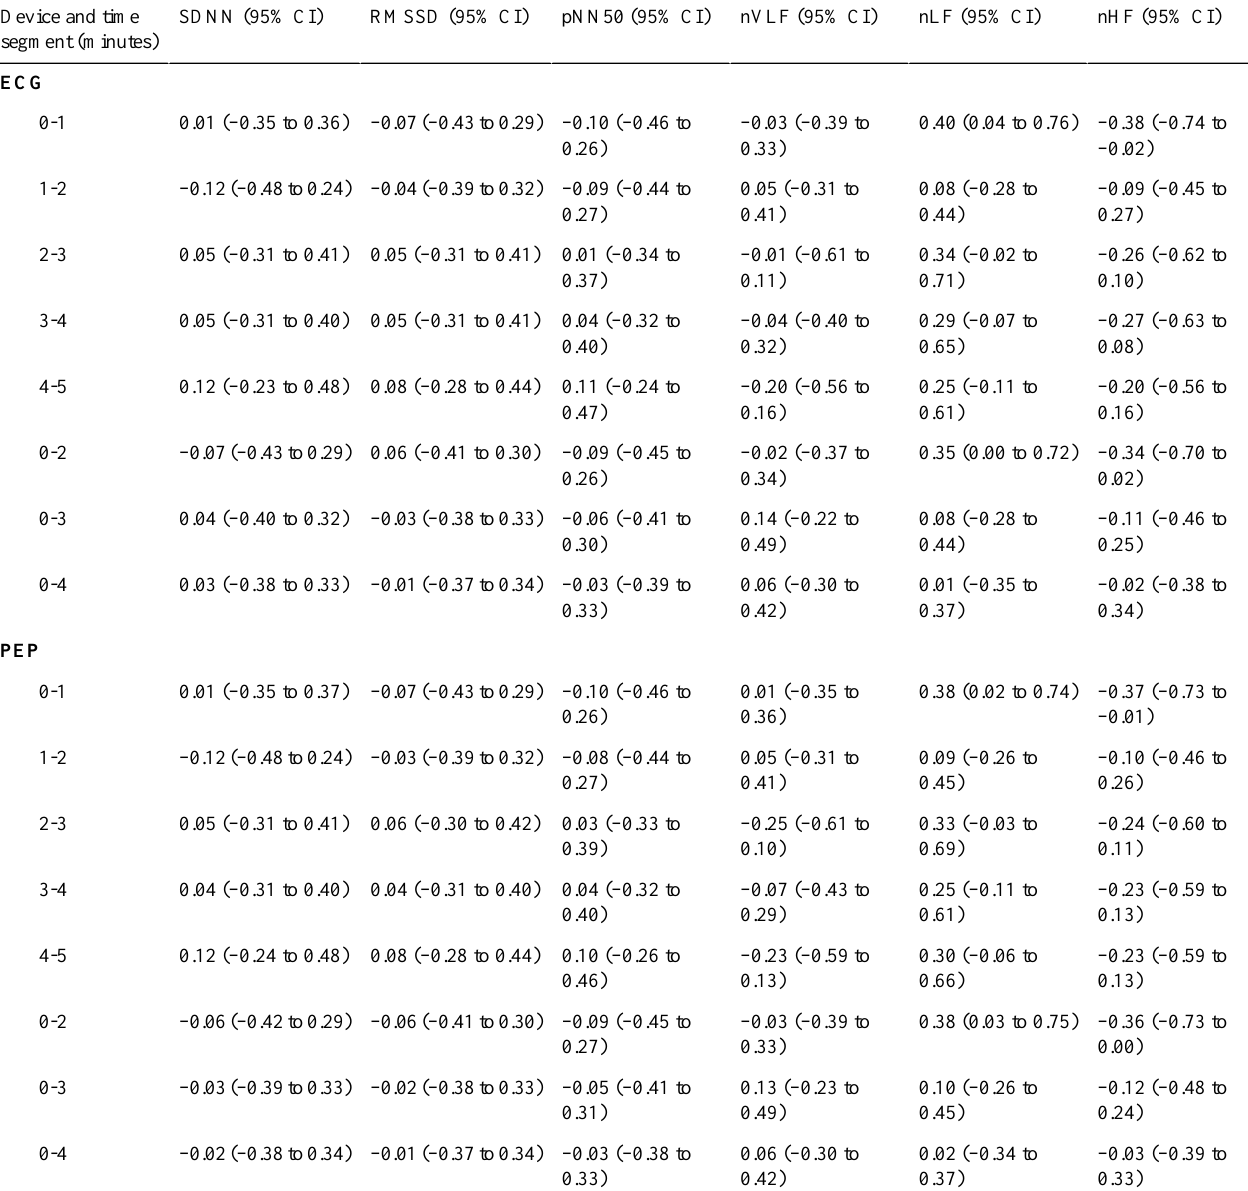
Table 2. Standardized differences (95% CI) of time-domain and frequency-domain heart rate variability parameters in different time segments of the electrocardiogram and Pulse Express PRO measurements compared with the 0-5–minute standard a